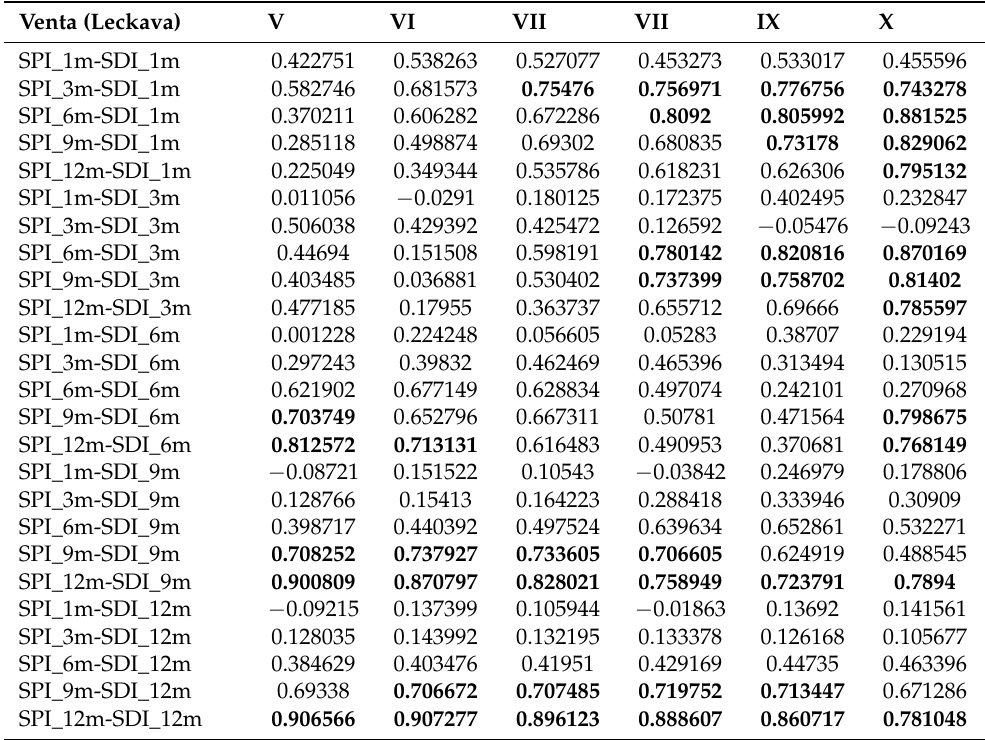
Table A5. Correlation matrix between RDI and SDI indices for the Venta